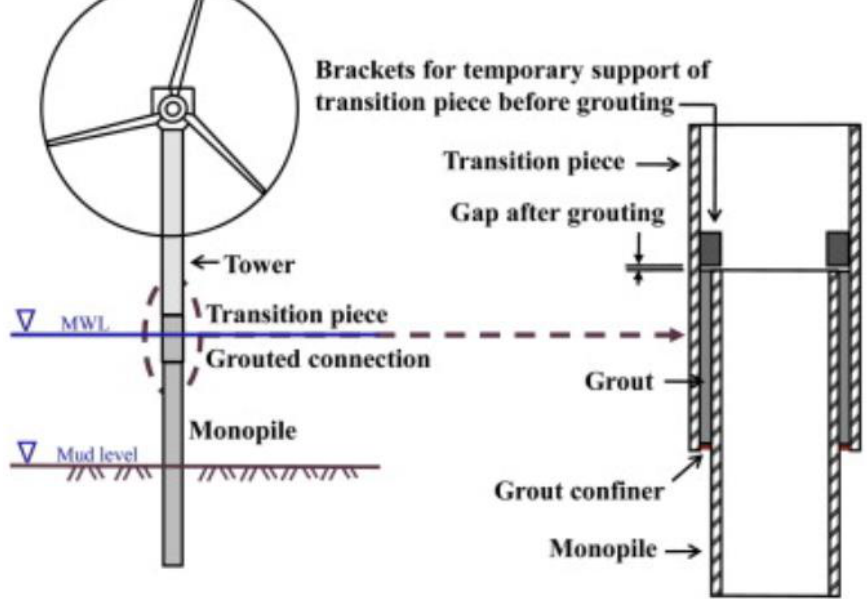
Figure 1. Traditional grouted connection (adapted from [7], with permission from Wiley-VCH Verlag GmbH & Co. KGaA. 2014.).